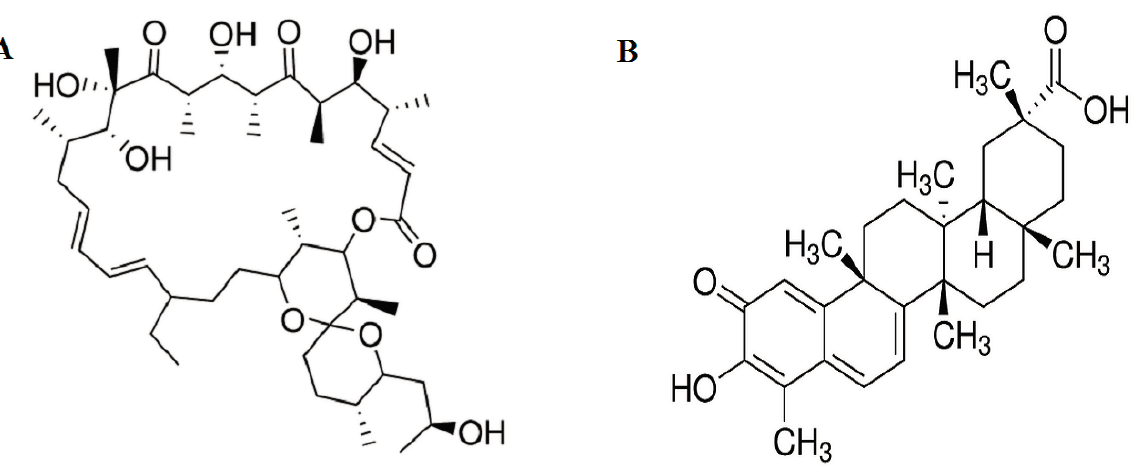
Figure 1. Effects of oligomycin and celastrol on cell viability. Chemical structures of ( A ) oligomycin and ( B ) celastrol were shown; The ( C ) dose-response and ( D ) time course of the cell viability for oligomycin and celastrol was determined via MTT assay. After serum starvation, the fully differentiated 3T3-L1 adipocytes were incubated with different doses of oligomycin (5, 10, 20 and 30 µg/mL) and celastrol (5, 10, 20 and 30 μ M) in DMSO for 48 h. Time-course dependent (0, 12, 24, 36 and 48 h) was determined for each optimal dose. Effect of oligomycin and celastrol on nuclear factor kappa B (NF- κ B) expression was performed via ( E ) immunoblotting analysis. β -actin was used as loading control. Protein levels measured were normalized against β -actin. Results were expressed as means ± SEM ( n = 6–8). * p < 0.05 vs . untreated